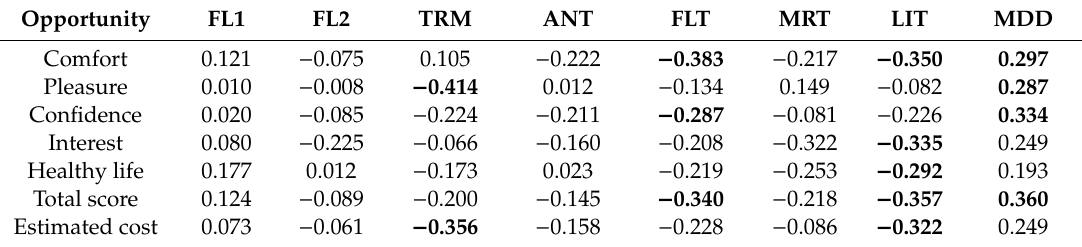
Table 3. Correlation coe ffi cients between resource tier scores and welfare outcome measures.